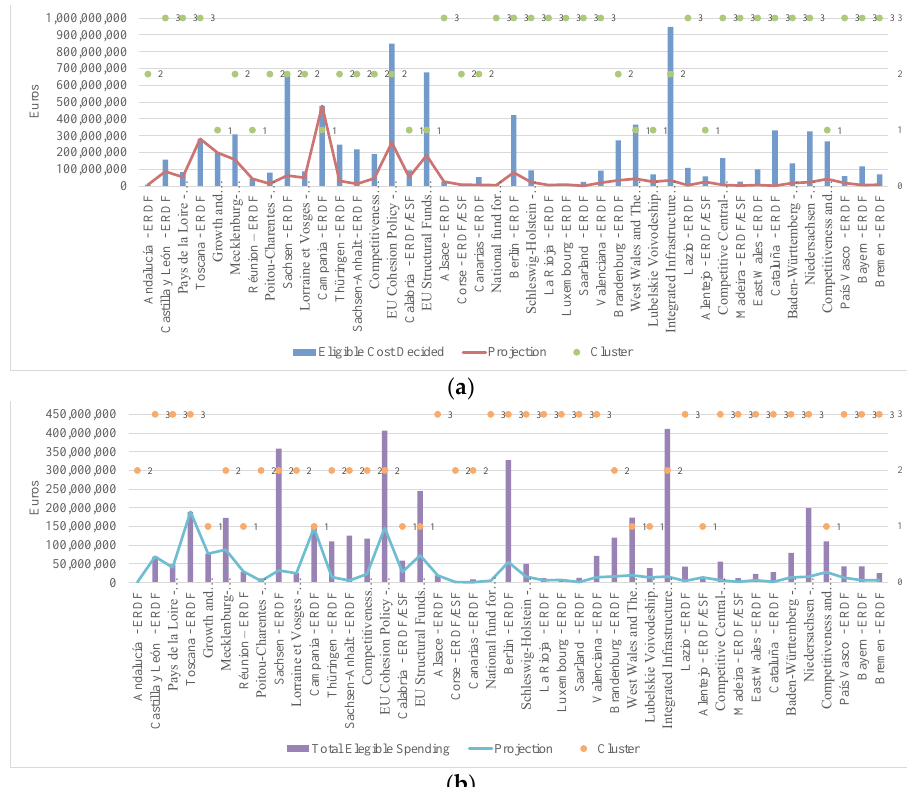
Figure 5. Potential improvement of each external output for procedural efficiency ( a , b ) and R&I efficiency ( c , d ) for every inefficient OP according to the network model and the cluster-frontier. Note: 1 — Less Developed, 2 — Transition, 3 — More developed.